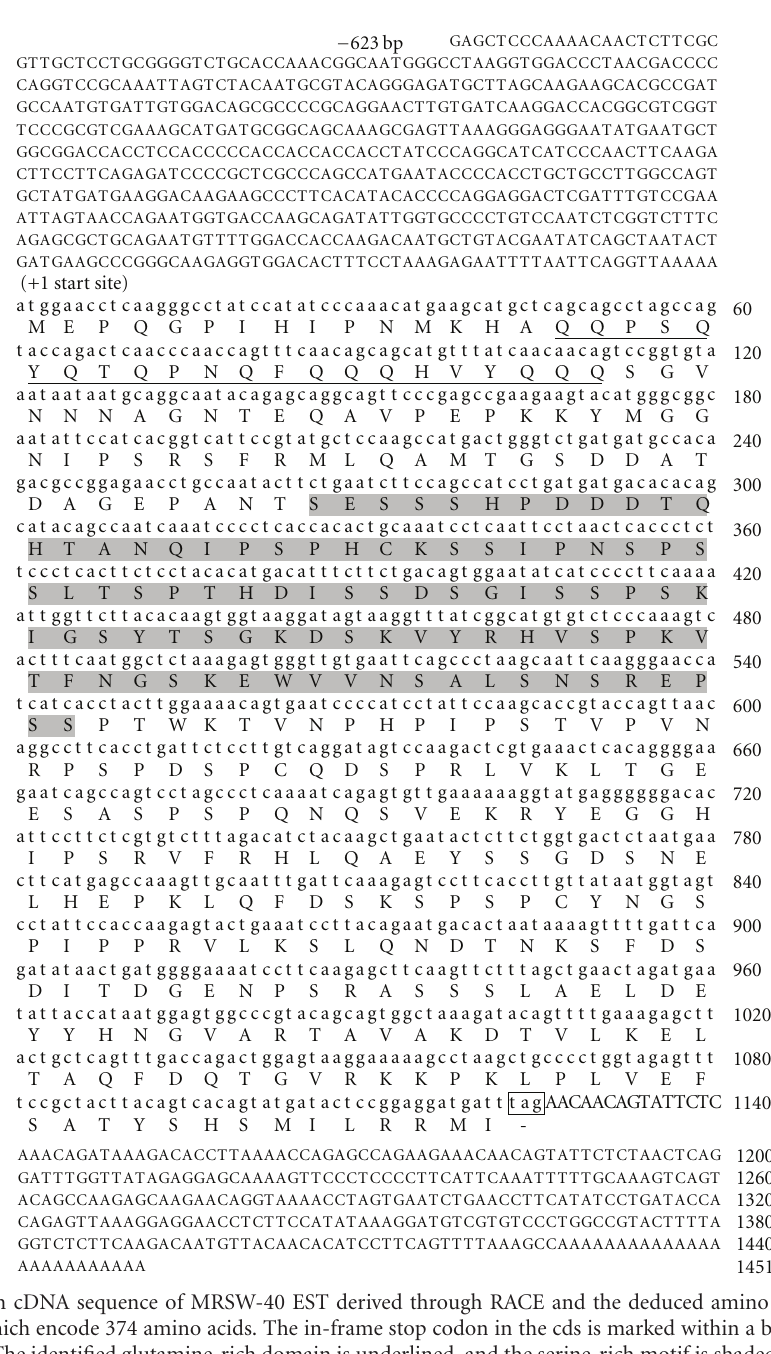
e ffi ciently enriching a subset of genes that are up-regulated by salinity stress in the gill of M. rosenbergii . We have iden- tified 26 ESTs encoding regulatory proteins associated with biological processes of salinity stress